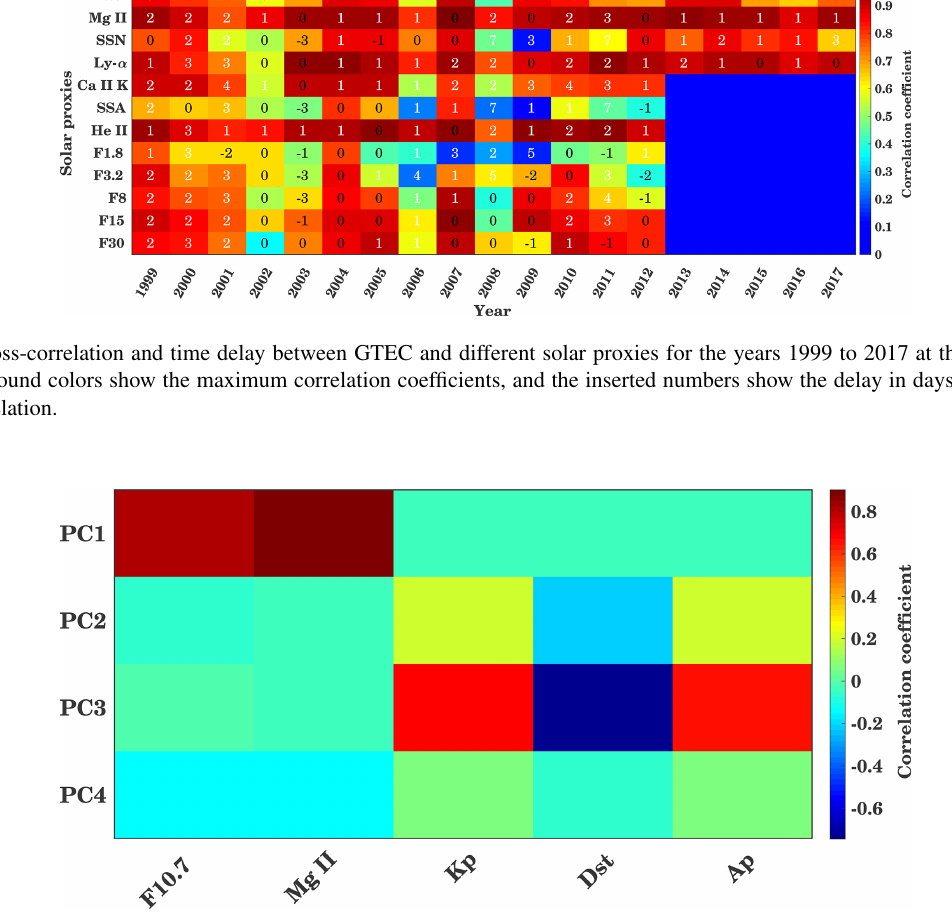
Figure A4. Correlation coefficients between the PCs and solar and geomagnetic proxies at lag 0.